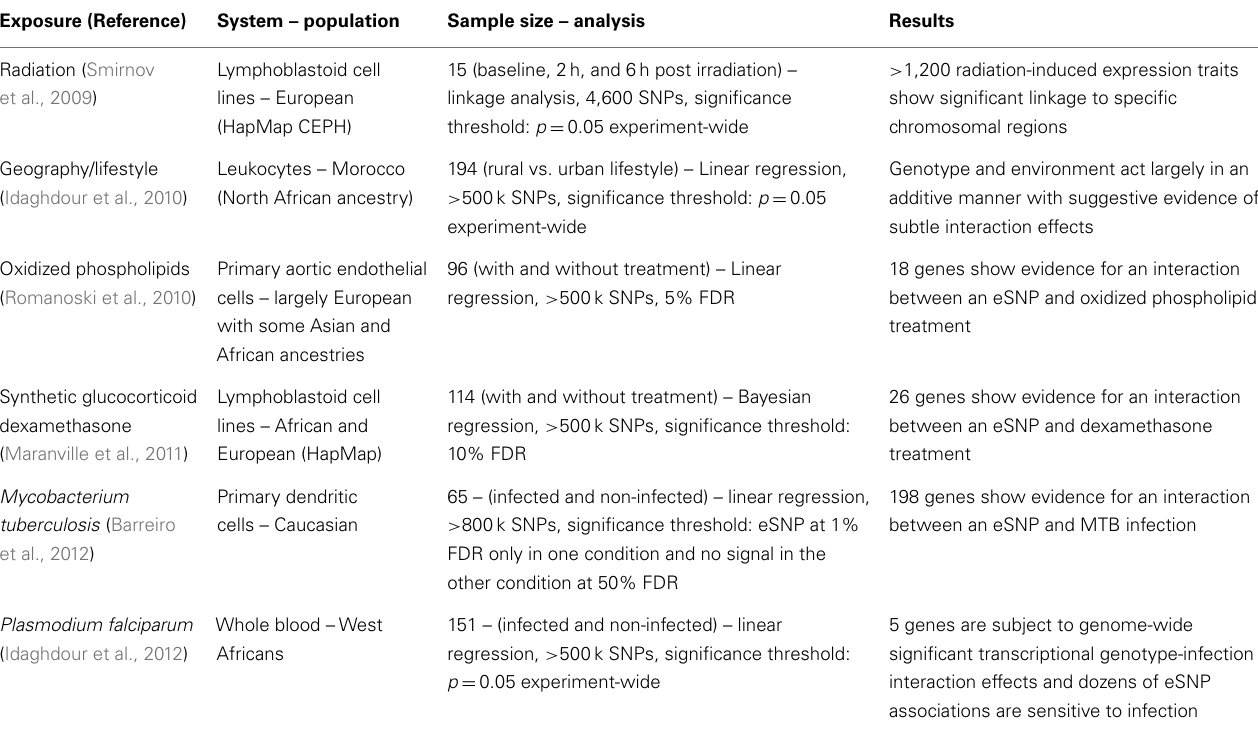
Table 1 | Recent published genome-wide surveys of transcriptional genotype-environment